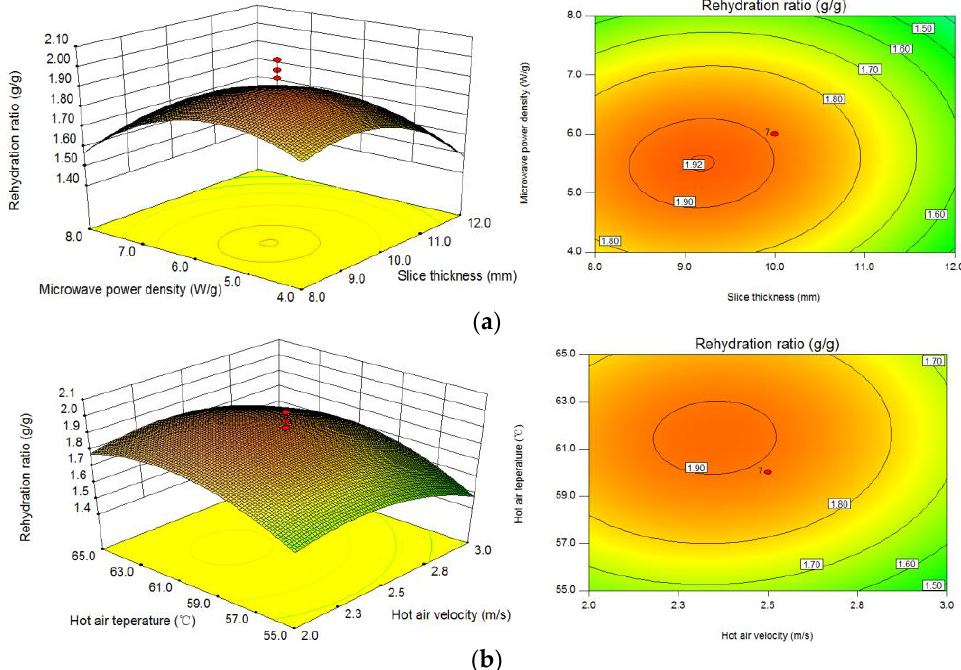
Figure 4. Response surface plots of RR between variables. ( a ) Slice thickness and microwave power density; ( b ) Hot air velocity and hot air temperature.